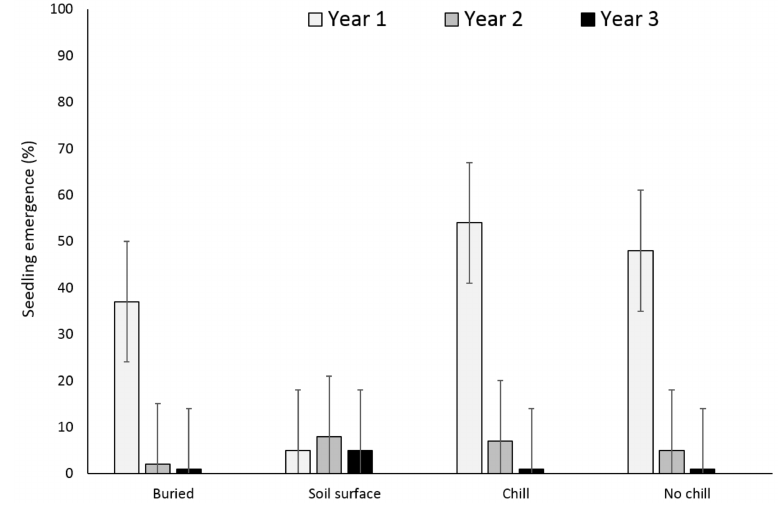
Figure 2. Effect of environmental conditions on S. obtusifolia emergence originating from a single maternal source. Vertical bars represent LSD at 5% significance